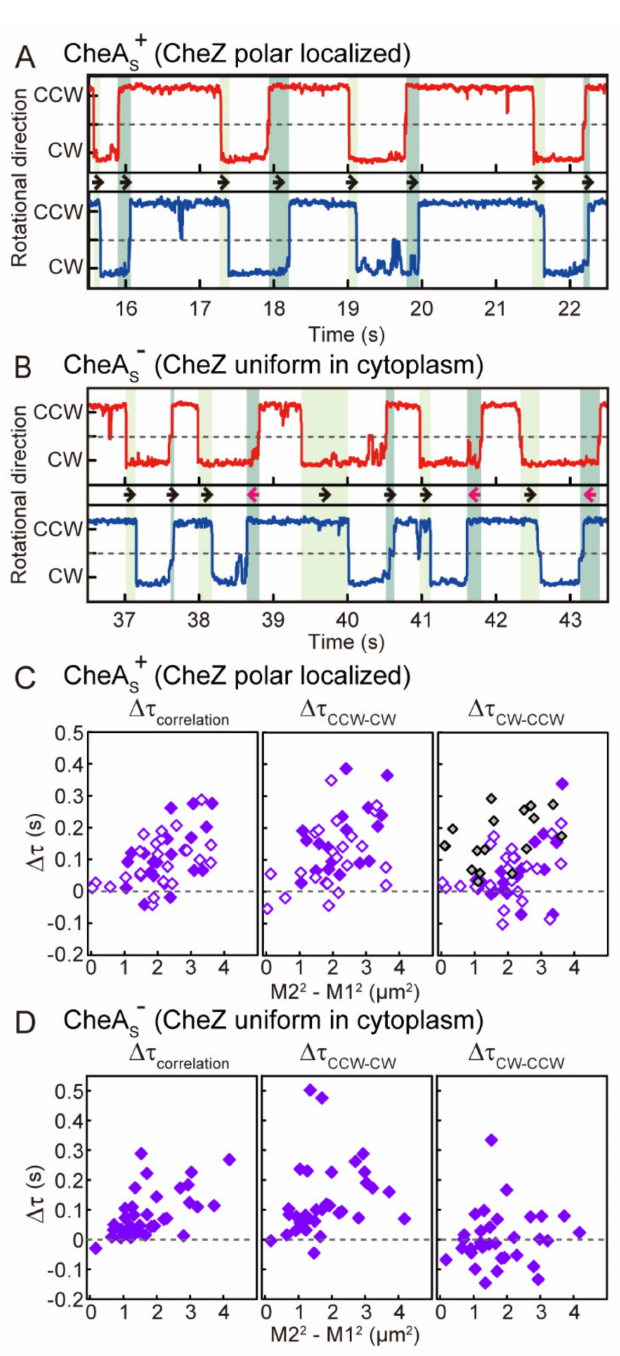
Figure 3. Time lags between switching of the two motors as a function of the distance from the polar chemoreceptor array. ( A ) The time traces of the rotational directions of the proximal motor 1 (red) and the distal motor 2 (blue) of a CheA S + cell, shown in Figure 1B, over a short time period. Light-green and dark-green hatched areas indicate the time lags of switching between the two motors from CCW-to-CW and CW-to-CCW, respectively. Forward arrows indicate that switching of motor 1 preceded that of motor 2. ∆ τ CCW-CW , ∆ τ CW-CCW , and M2 2 -M1 2 values of this cell are 0.16 s, 0.03 s, and 1.21 µ m 2 , respectively. ( B ) The time traces of the rotational directions of the proximal motor 1 (red) and the distal motor 2 (blue) of a CheA S − cell, shown in Figure 2B, over a short time period. Colored hatches are as in ( A ). Forward arrows indicate that switching of motor 1 preceded that of motor 2, and reverse